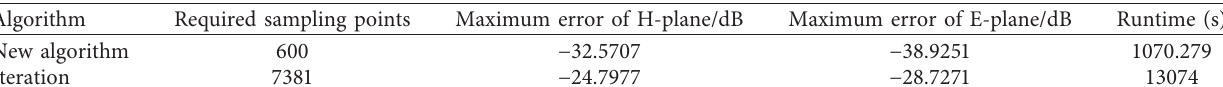
Table 5: The required near-field sampling points, runtime, and accuracy of the algorithm proposed in this study along with the method in [6, 8, 35].